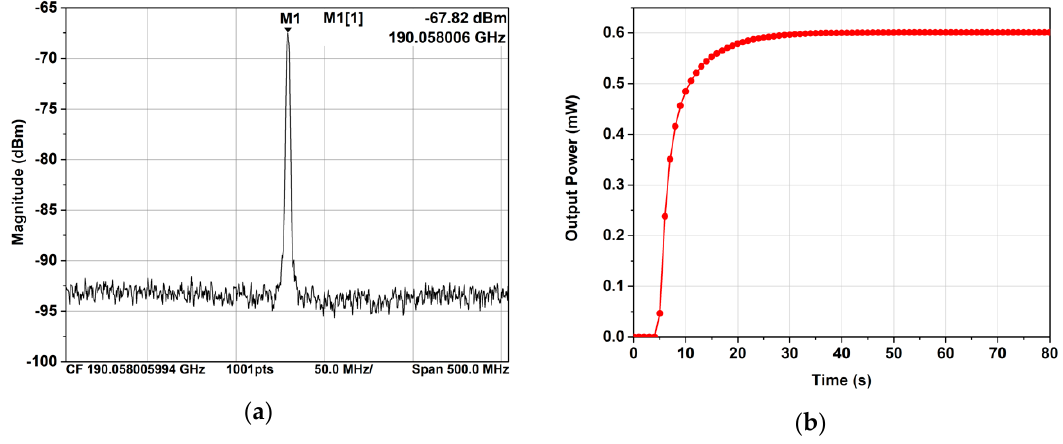
Figure 8. Measured ( a ) output spectrum; ( b ) output power of the proposed oscillator.